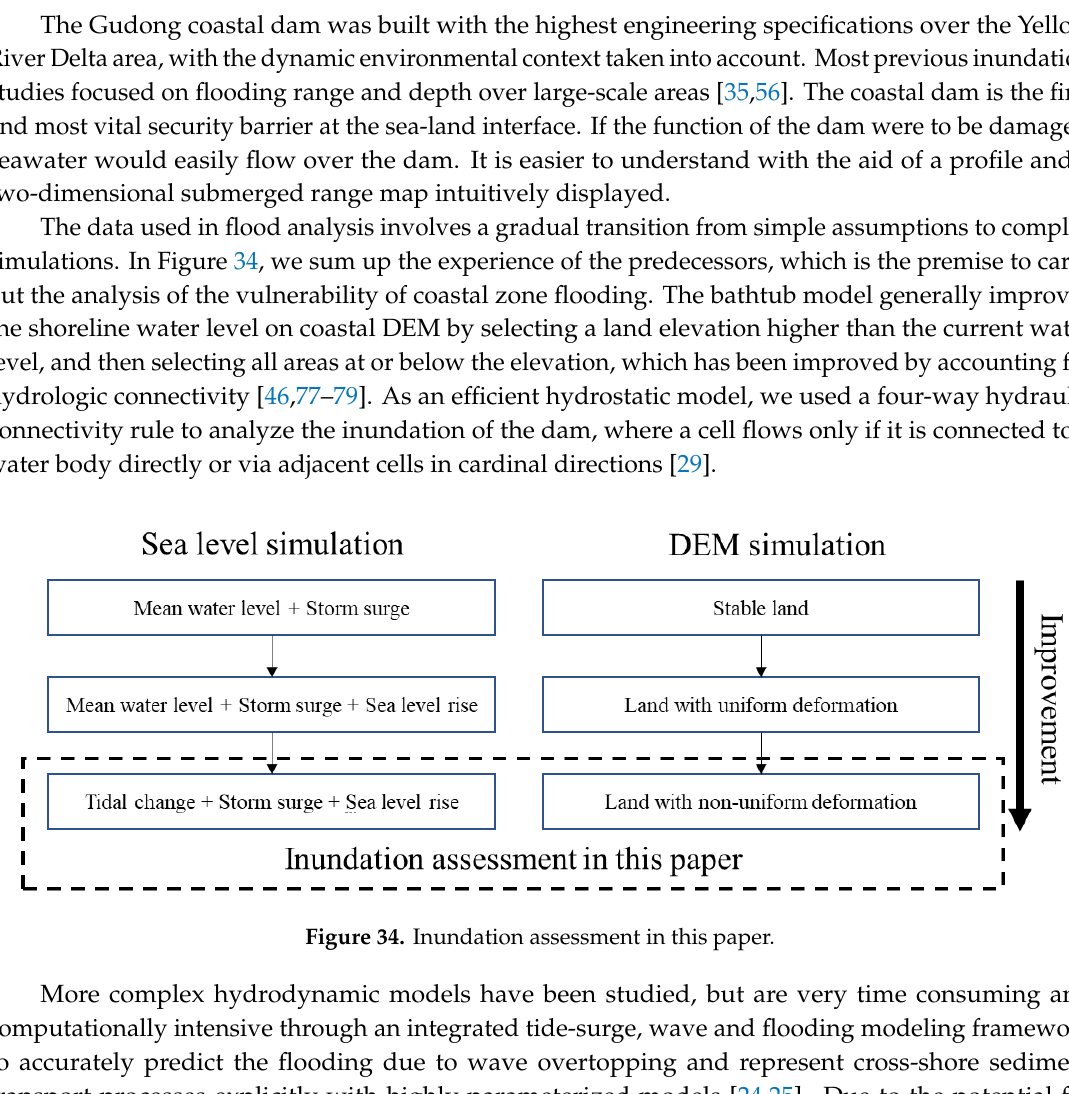
Figure 33. Schematic diagram of danger range of sea level change.